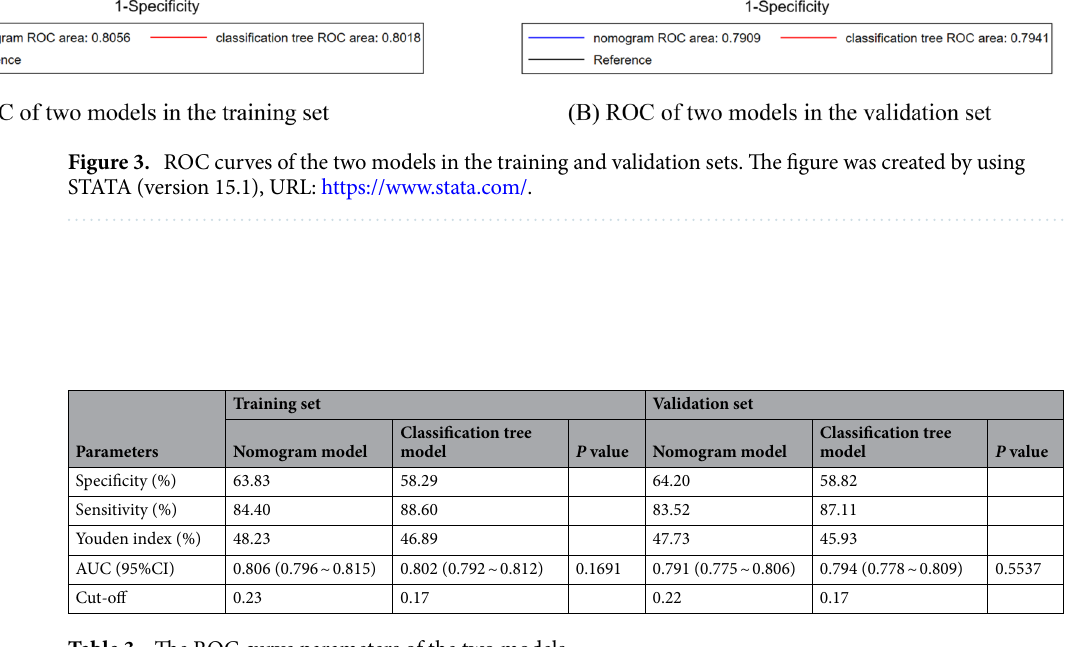
Table 3. The ROC curve parameters of the two